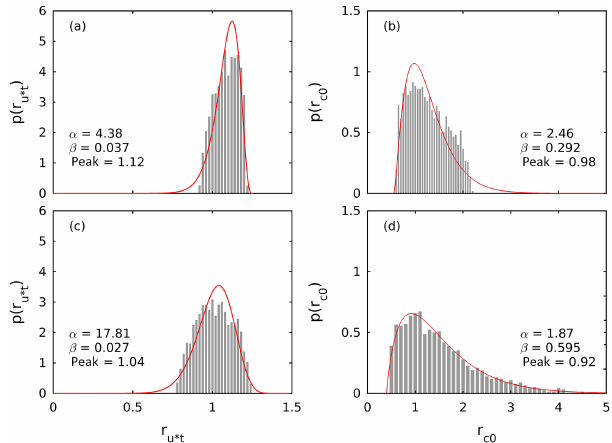
) for 1min averaged saltation ∗ t ) ; (c) and (d) , as (a) and (b) but for 0